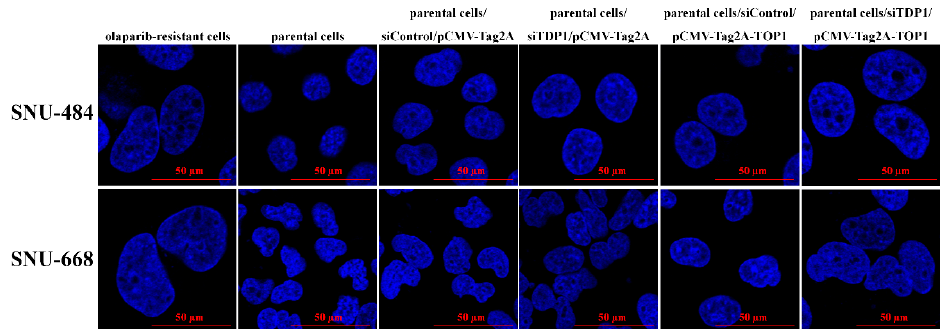
Figure 6. Parental cells were transfected with siRNA targeting TDP1 and/or pCMV-tag2A-TOP1 for 5 d. The size of nuclei was measured by DAPI staining and confocal laser microscopy. Representative images are presented (80× original magnification). Scale bars represent 50 μ m.